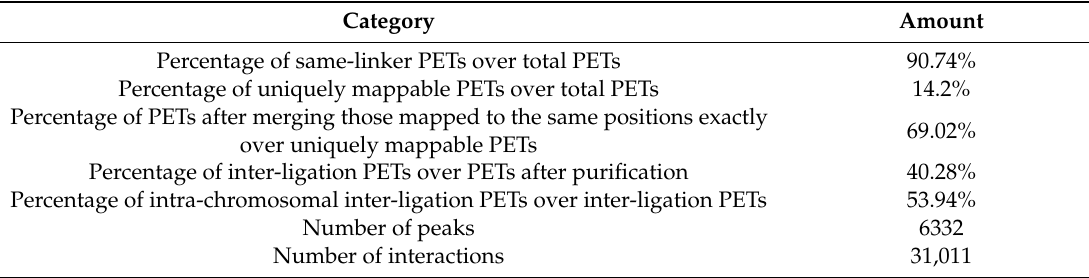
Table 5. Statistics of ChIA-PET library from human K562 cells.